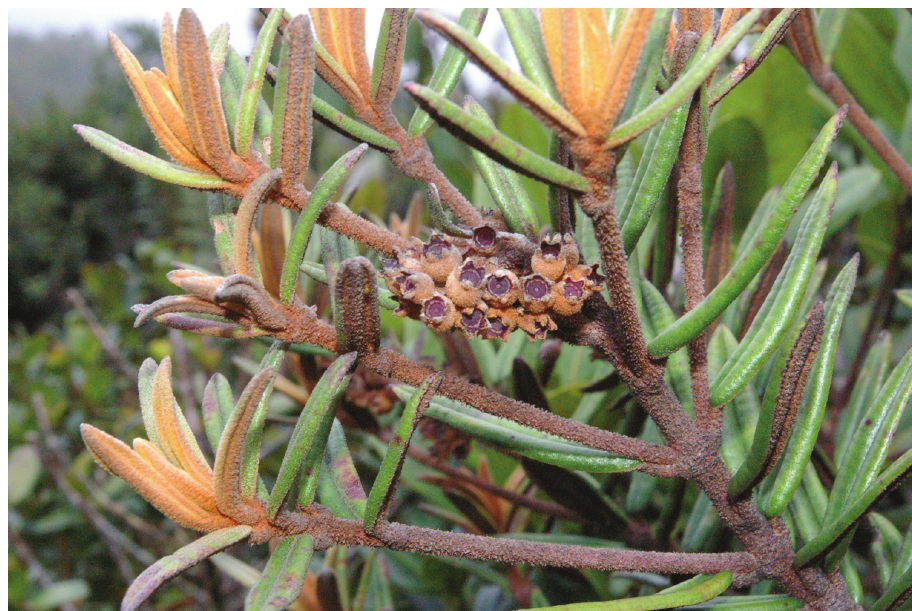
Figure 4. Miconia machinazana, fruiting branch, Neill 16167 (photograph D.A.